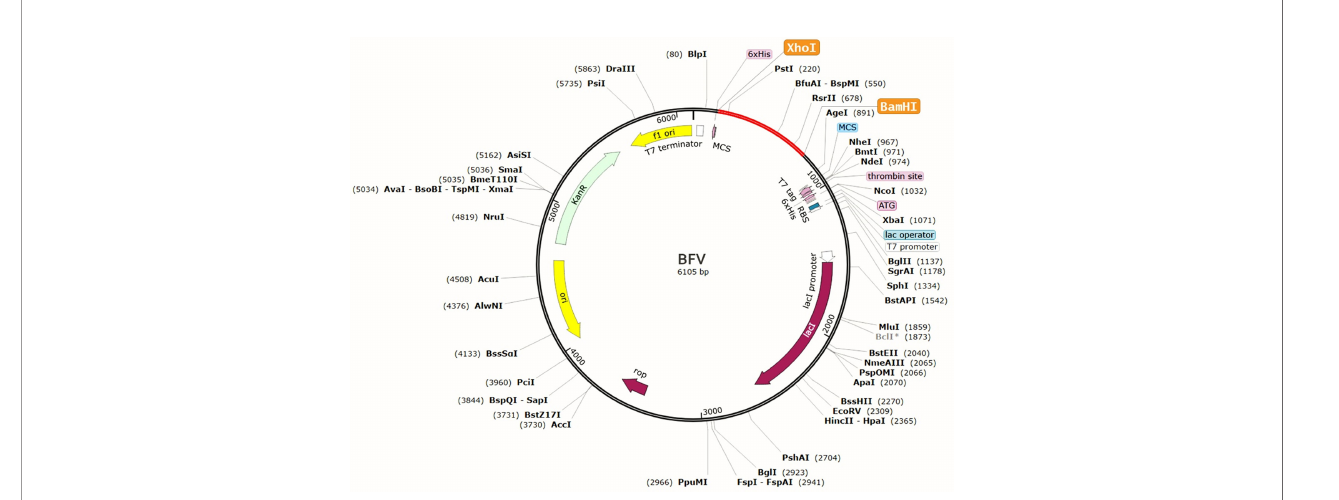
FIGURE 10 | Recombinant pETite vector plasmid with the BFV vaccine inserted (marked in red color) between the XhoI and BamHI restriction enzyme